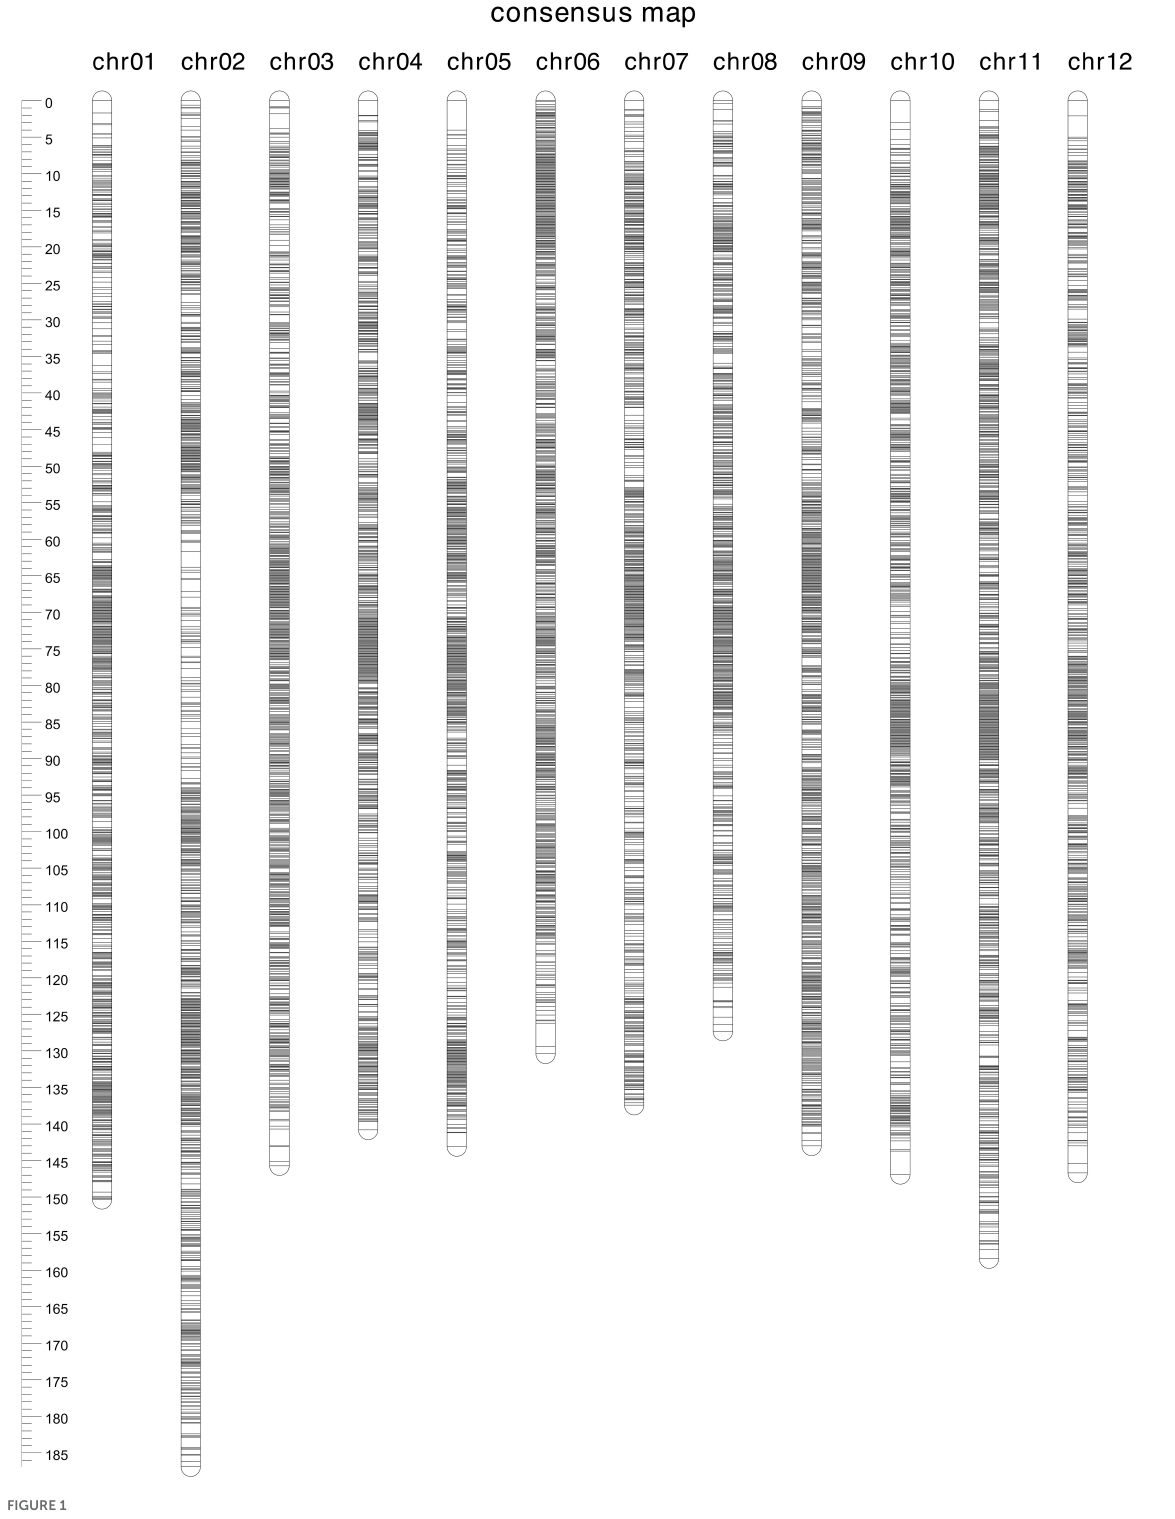
FIGURE1 Linkage map of “Hortblue Petite” ×